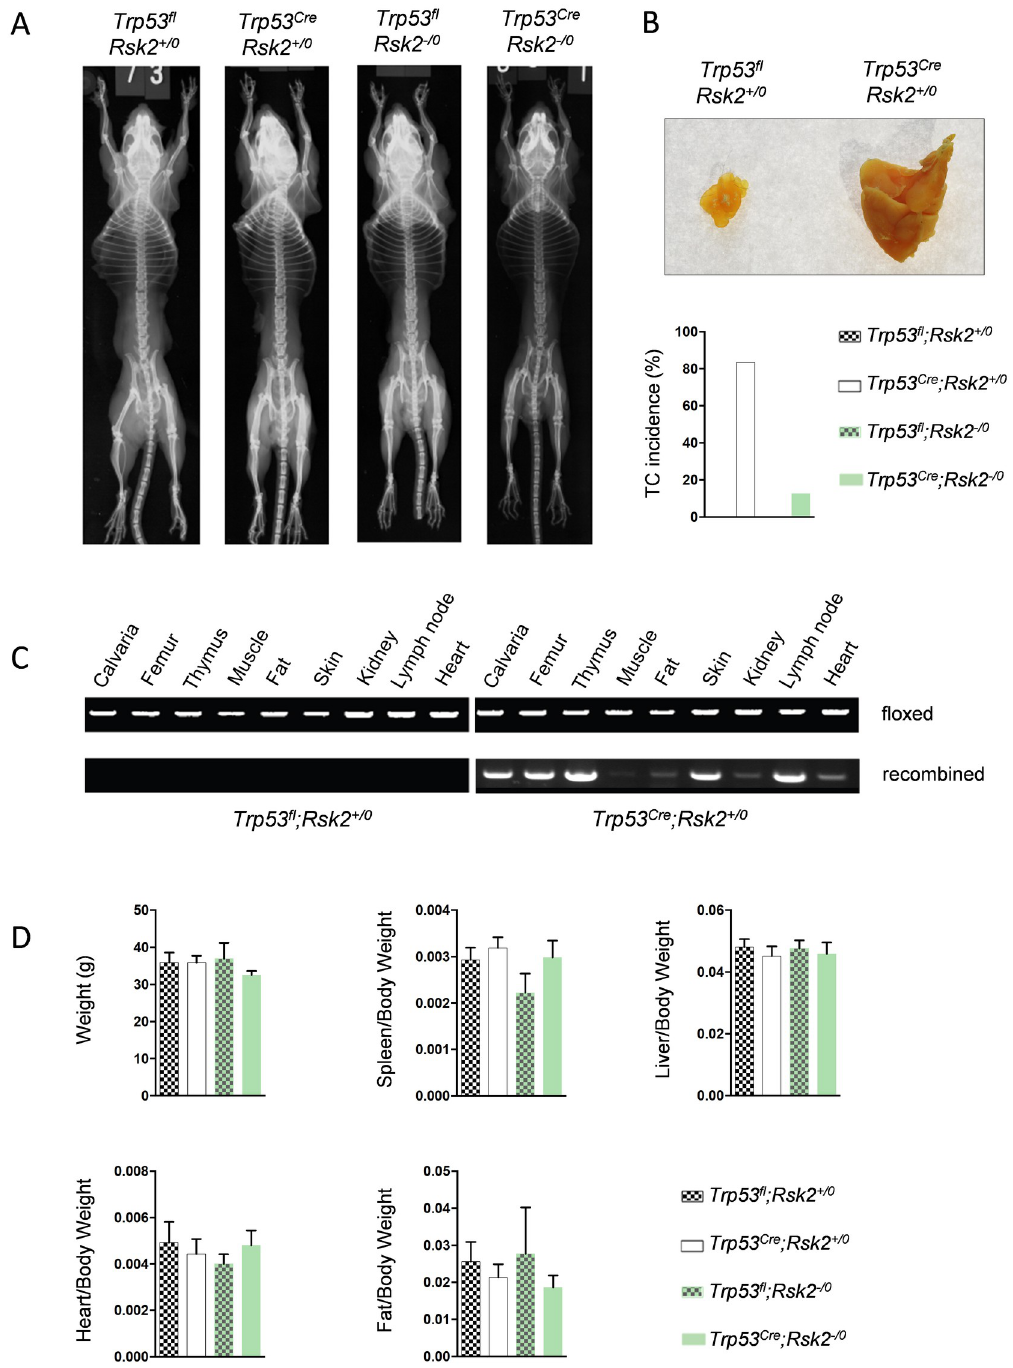
Fig 1. Trp53 Cre mice develop thymic lymphomas, but no osteosarcomas. (A) Representative contact Xrays of 6-month-old male mice with the indicated genotypes. (B) Representative images showing a thymic lymphoma in a 6-month-old Trp53 Cre mouse. Quantification of the thymic lymphoma incidence is given below. (C) Genomic PCR amplification of the floxed and recombined Trp53 allele with DNA obtained from the indicated tissues of Trp53 fl or Trp53 Cre mice. (D) Quantification of body and organ weights in the different groups of mice. Data represent mean ± SD (n �